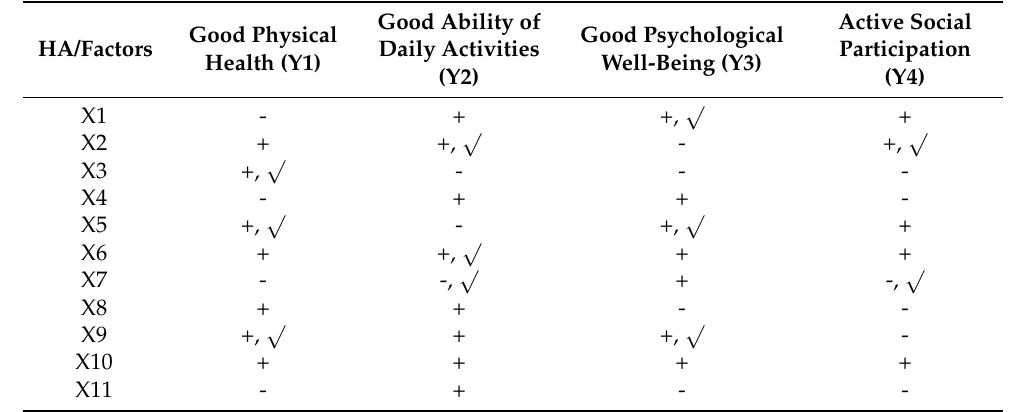
Table A10. Statistical comparison of